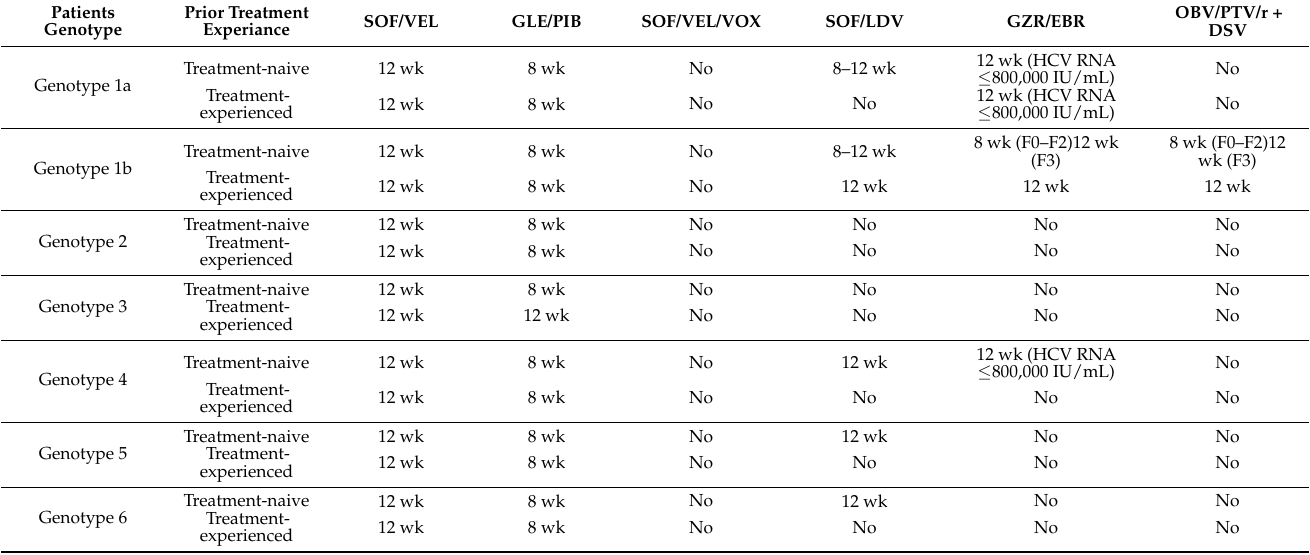
Table 1. Treatment modalities for patients without liver cirrhosis [39].